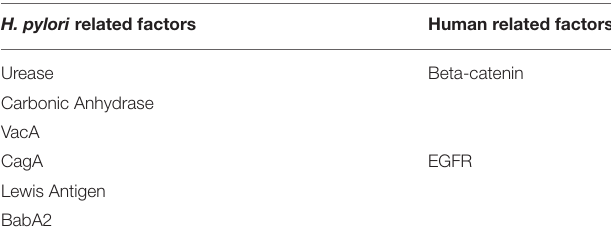
TABLE 1 | Shows some factors that govern H. pylori —human (host) that mediates